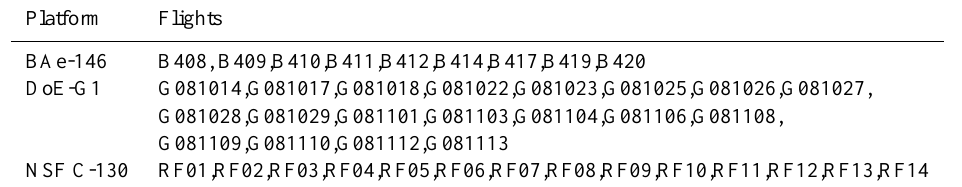
Table 1. Flight designators for data used in this study. Flights with the prefix “B” define those by the BAe-146, “RF” corresponds to the NSF C-130 and “G” to the DoE-G1 aircraft.